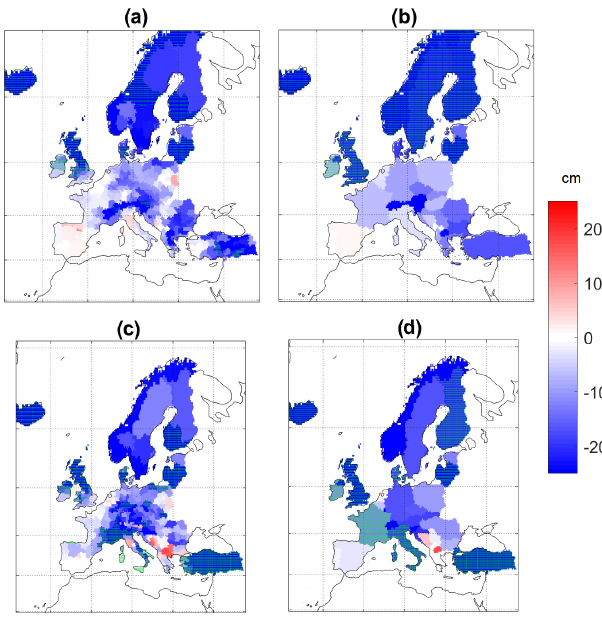
Figure 1. Yearly total snowfall (SF; average 1979–2018) for the ERA5 (a, b) and the E-OBSv20.0e (c, d) datasets. (a, c) NUTS-0 level, (b, d) NUTS-2 level.